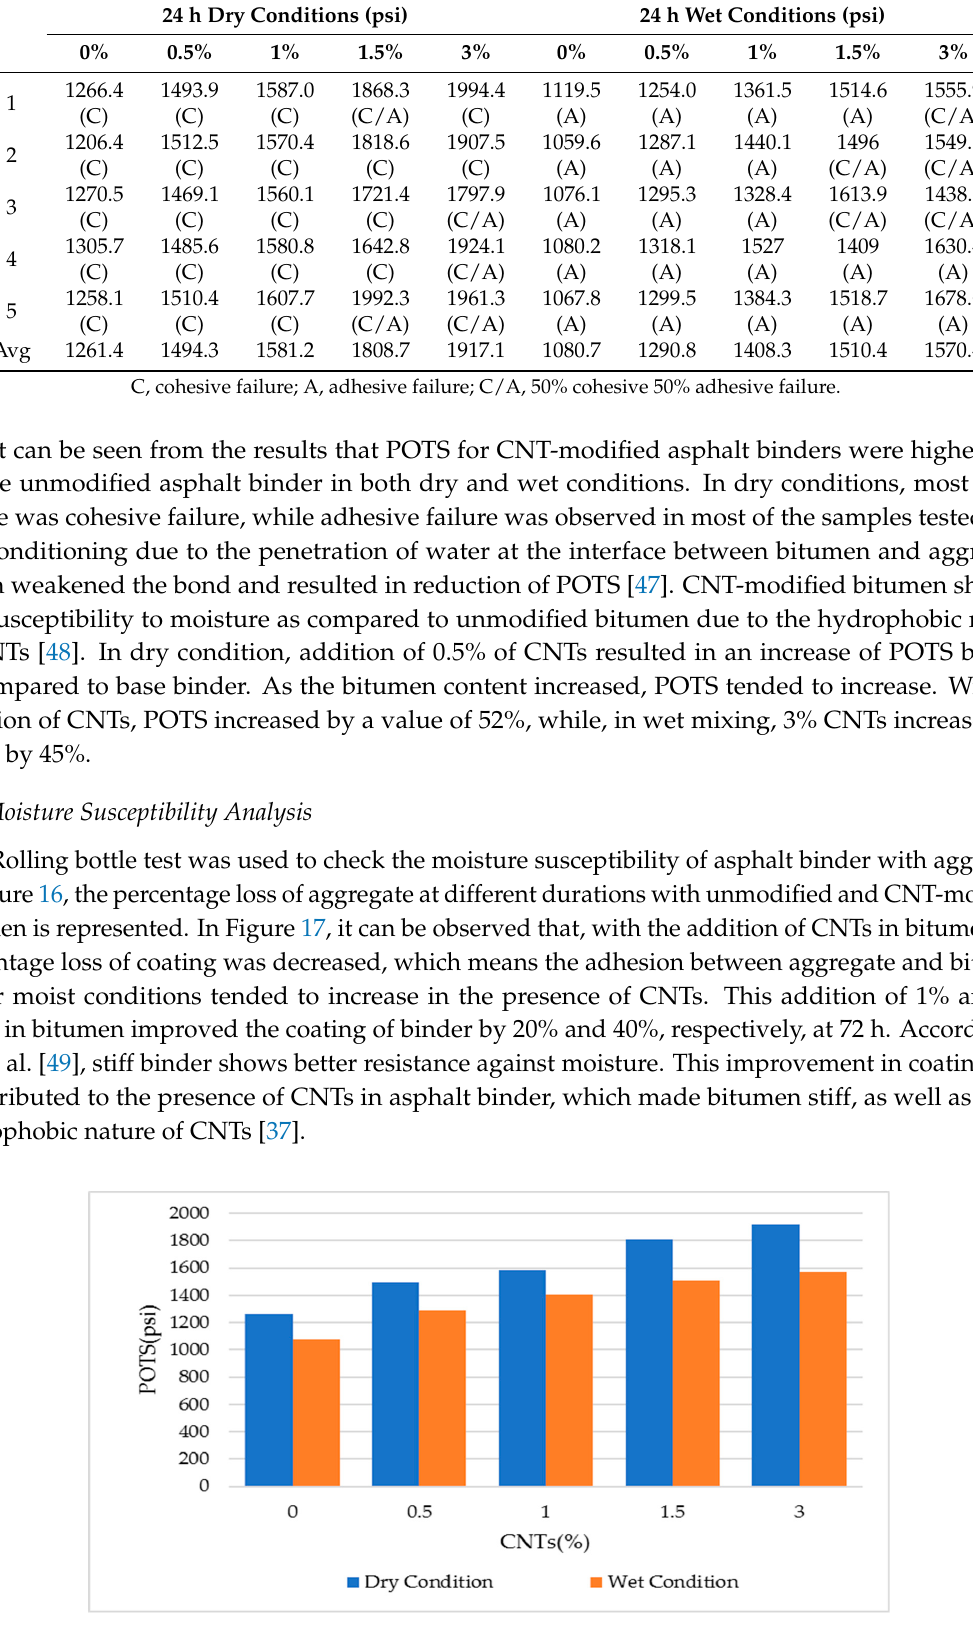
Table 6. POTS (psi) of unmodified and CNT-modified binders and failure pattern.